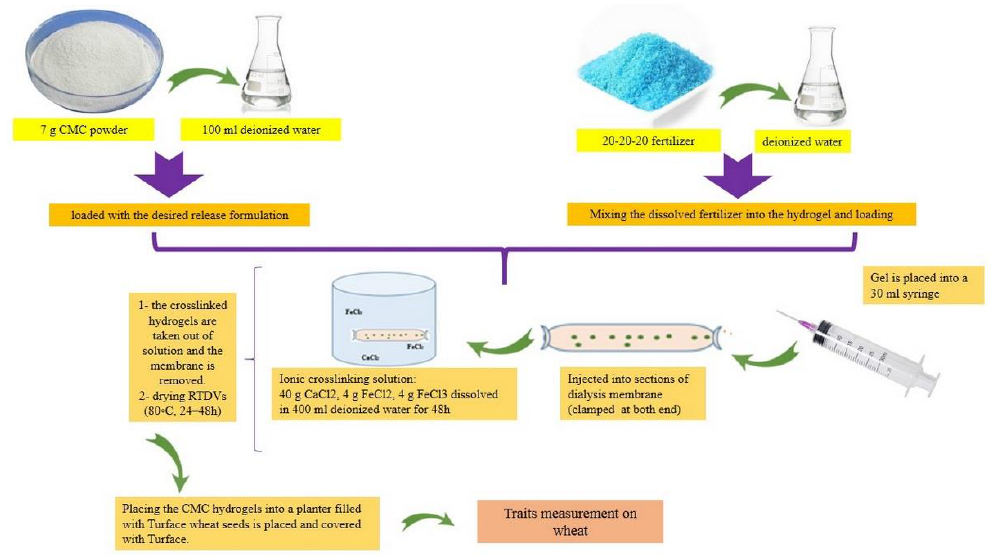
Figure 5. Root-targeted delivery vehicle (RTDV) synthesis as a targeted delivery